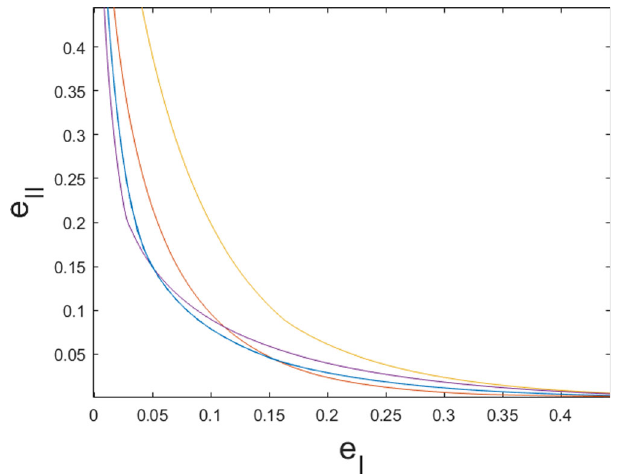
Fig. 5 Comparison of independent repetitions of 1-shot and 3-round (cid:4) (cid:5) (cid:11) (cid:4) (cid:4) (cid:4) g , in terms of the trade-off between type-I error, e ϕ games for E ¼ f ϕ I , (yellow), G ð 30 Þ (red) and G ð 30 Þ and type-II error, e II . The games G ð 30 Þ 22 25 28 (purple) are obtained through 30 independent repetitions of optimal one- shot games G restricted to measurements in M 2 . These are compared to the optimal 3-round adaptive protocols G 0 with measurements M 2 performed in each of the three rounds, independently repeated 10 times as G 0 ð 10 Þ (blue). The 1 and 3-round games G and G 0 were also analyzed in 8 Fig. 4. We observe that the repetition of an adaptive protocol outperforms the others in the regime of low total error e I + e II